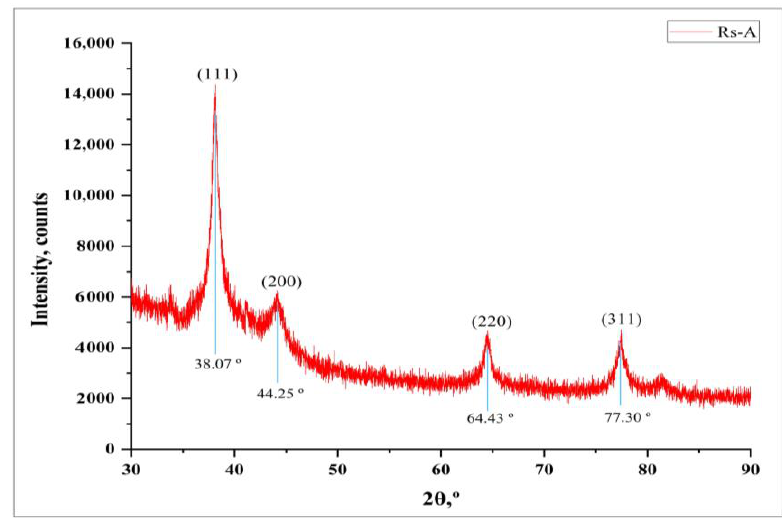
Figure 4. X-ray crystallographic analysis patterns of synthesized RsFb-AgNPs.